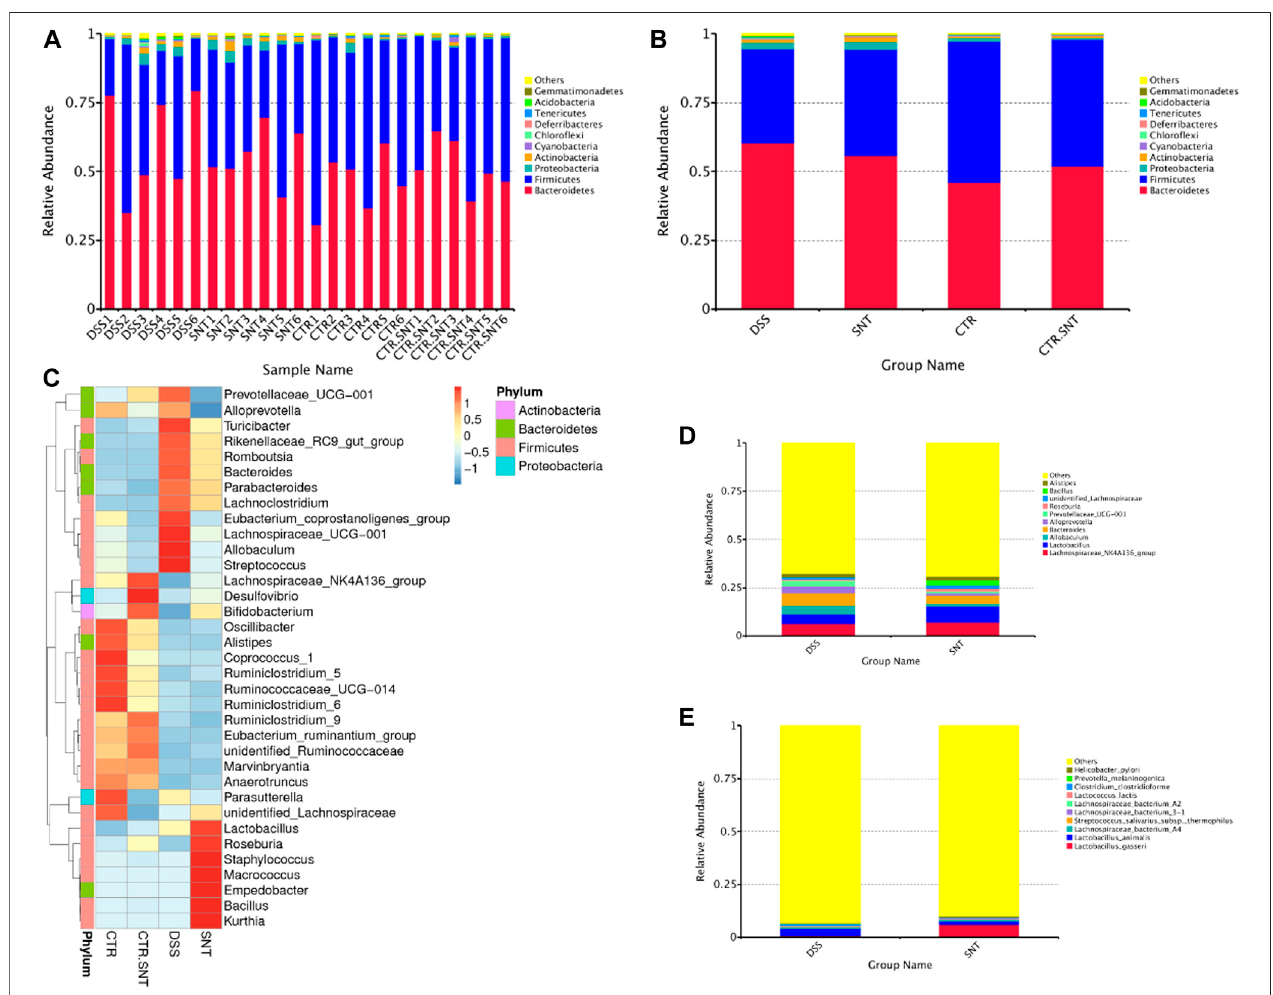
FIGURE 6 | The relative abundance of mouse intestinal microbiota. (A,B) The Relative abundance display of phylum-level species. (C) Phylum-level species abundance clustering heatmap. (D) Relative abundance display of genus-level species. (E) The relative abundance of species. Group information in Figure: CTR-CTL, DSS-CRC, SNT-CRC + SND, CTR.SNT-CTL +